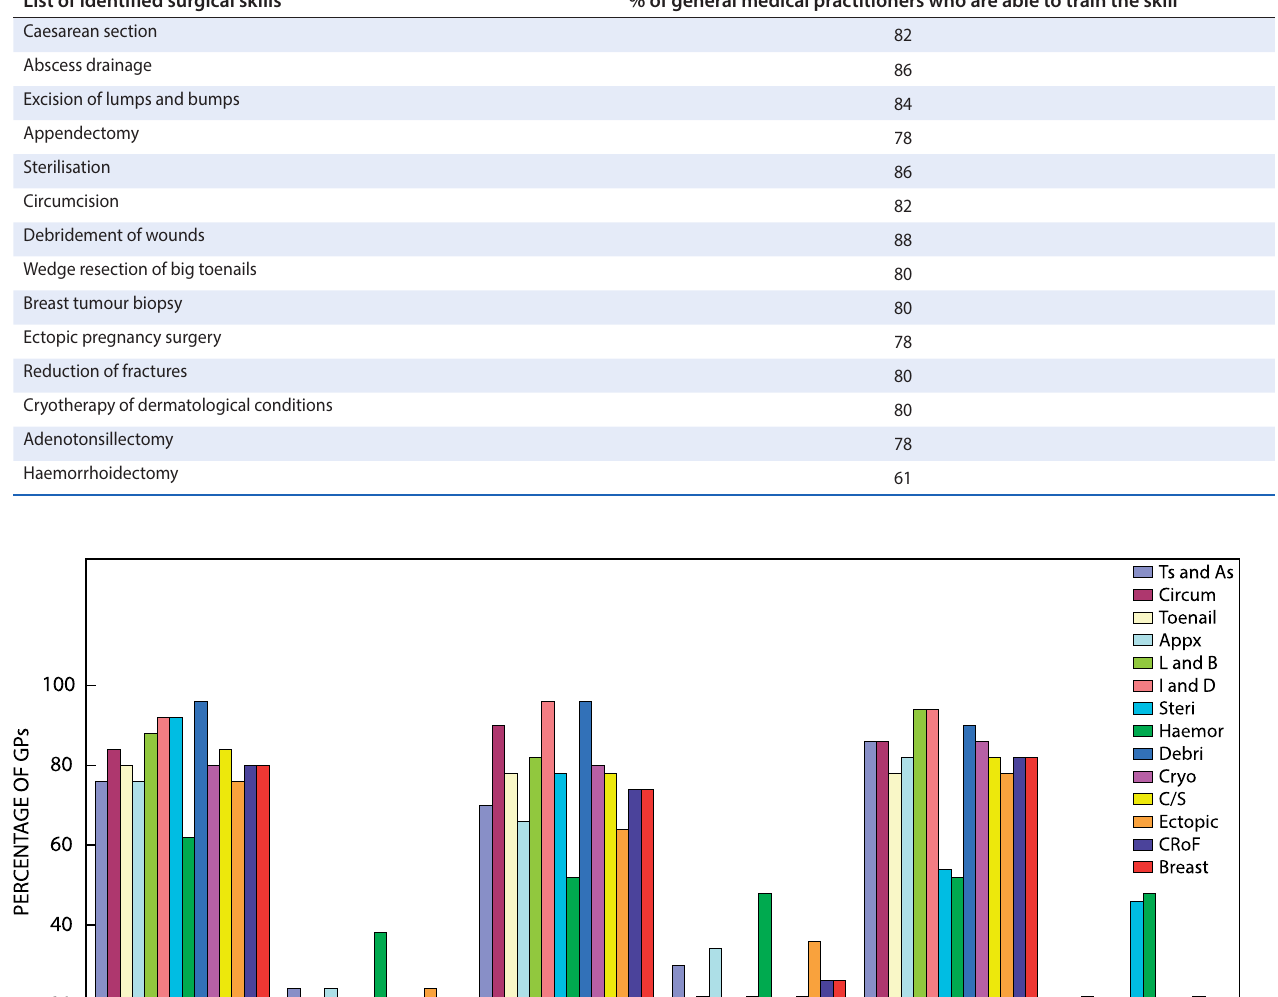
Table 3: General practitioners’ estimation of their ability to train interns on the core surgical skills List of identified surgical skills